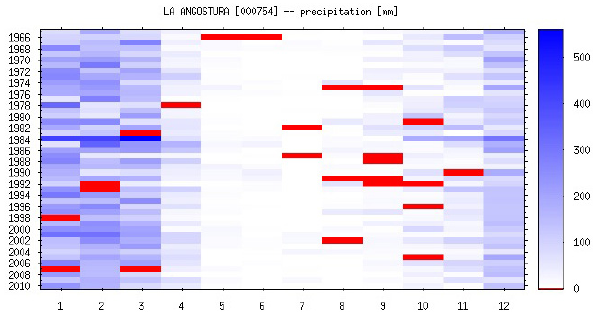
Figure 6. Matrix plot of monthly (aggregated from daily val- ues) precipitation sums for the precipitation station La Angostura (15.18 ◦ S, 71.65 ◦ W, 4150ma.s.l.) from January 1965 to Decem- ber 2010. The red bars are for monthly values having less than the predefined minimum number of plausible daily values required for the calculation of a monthly mean or sum.